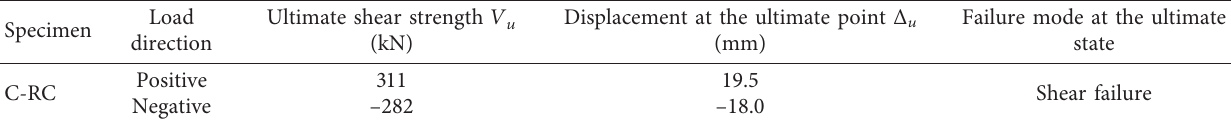
Table 5: Mechanical characterization of the control C-RC specimen during the cyclic loading test.